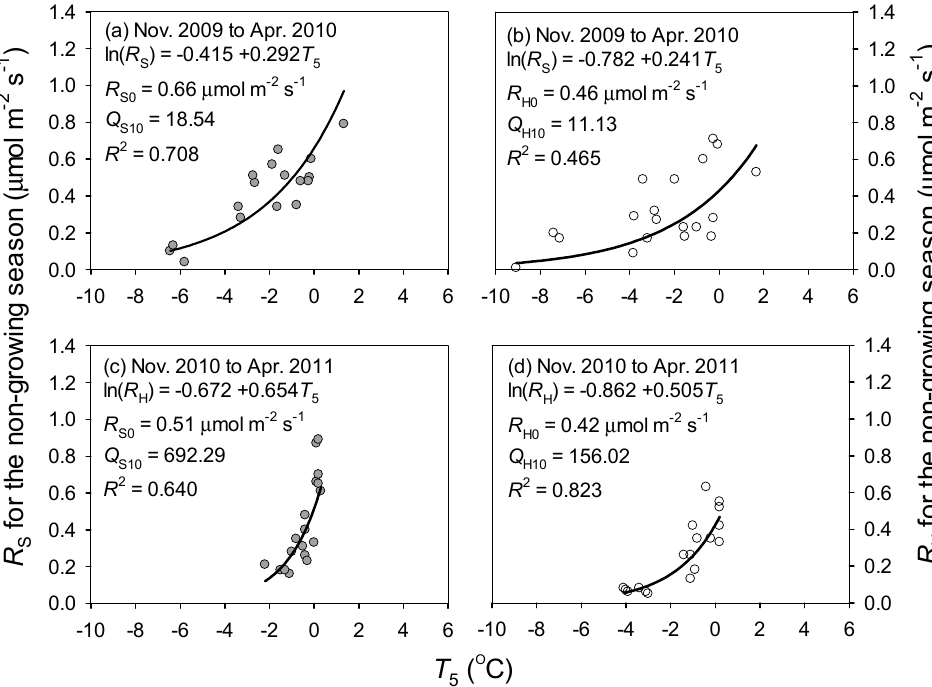
Figure 3. Relationships between soil temperature at 5 cm depth ( T 5 ) and ( a , c ) soil CO 2 effluxes ( R S ) and ( b , d ) CO 2 efflux from trenched plots ( R H ) during the growing season. The R S0 and R H0 are normalized respiration rate at 0 °C for R S and R H , respectively, and Q S10 , Q H10 are temperature sensitivities for R S and R H , respectively. All p -vales of the regression models were <0.001.